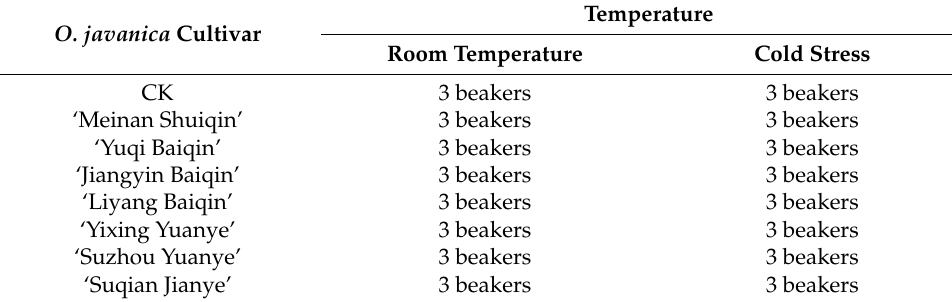
Table 2. Experimental conditions and test designations.